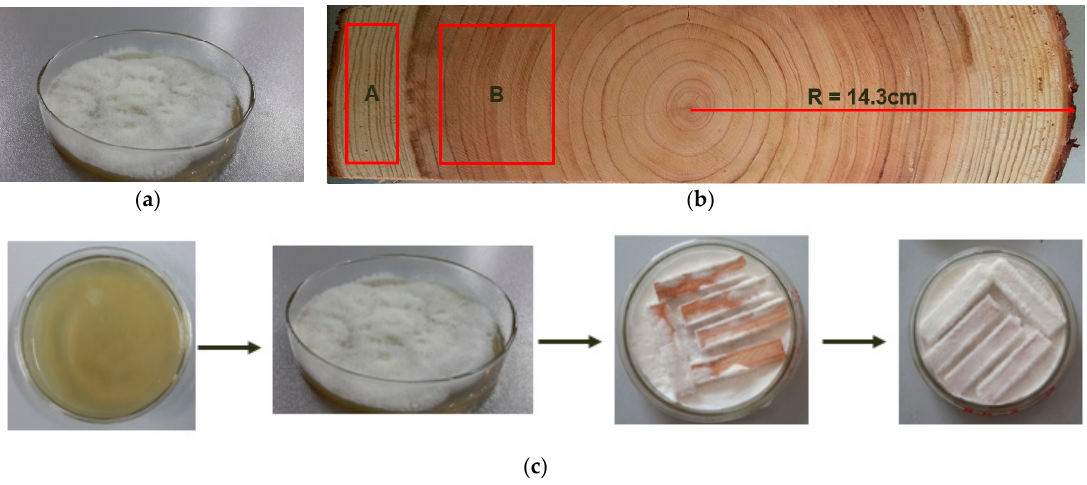
Figure 6. ( a ) Fungal pure cultures were held on the potato dextrose agar; ( b ) Wood samples and sampling areas; ( c ) Treated sample